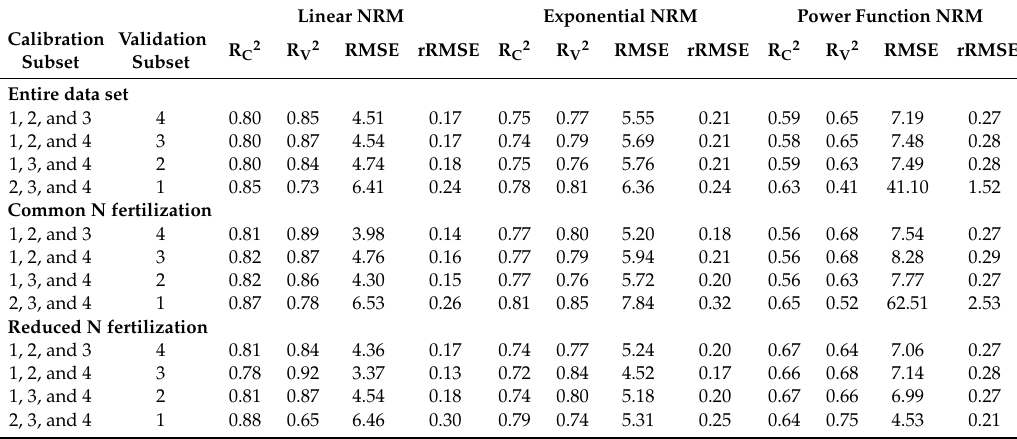
Table A3. Statistics for each run of the nitrogen regression models (NRMs) based on crop height (Calibration: R C2 : coe ffi cient of determination; Validation: R V2 : coe ffi cient of determination, RMSE: root mean square error (g / kg), rRMSE: relative root mean square error). Linear NRM Exponential